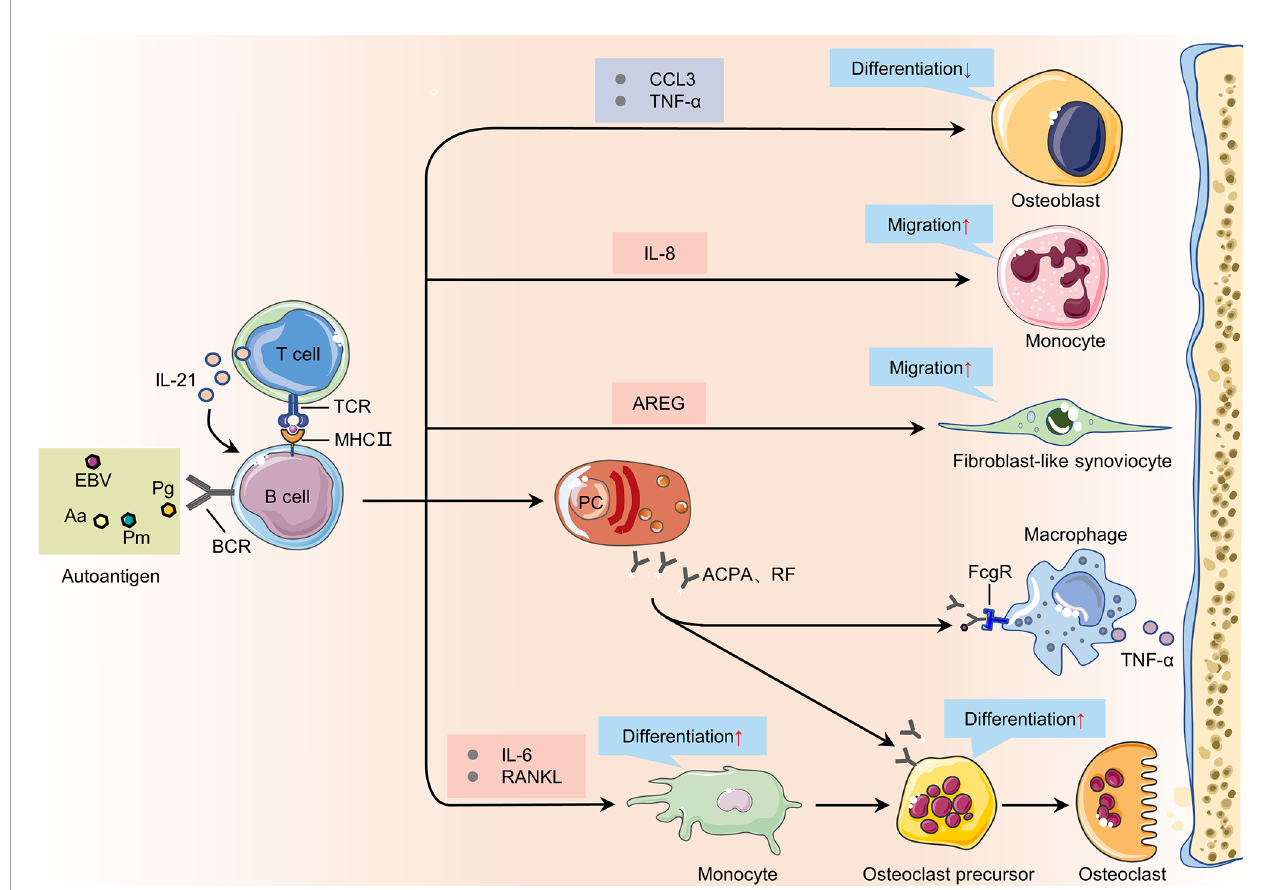
FIGURE 4 | The immunopathogenic role of B cells in rheumatoid arthritis. During the onset of RA, B cells can promote the activation, proliferation, and differentiation of other cells such as T cells, monocytes, and osteoclasts in the synovium by providing cytokines, autoantibodies and other mediators. TCR, T cell receptor; MHC II, major histocompatibility complex class II; TNF- a , tumor necrosis factor- a ; FcgR, Fcgamma receptors; AREG, amphiregulin; RANKL, receptor activator of nuclear factor kappa-B ligand; Pg, Porphyromonas gingivalis; Aa, Aggregatibacter actinomycetemcomitans; Pm, Proteus mirabilis; EBV, Epstein-Barr virus; PC, plasma